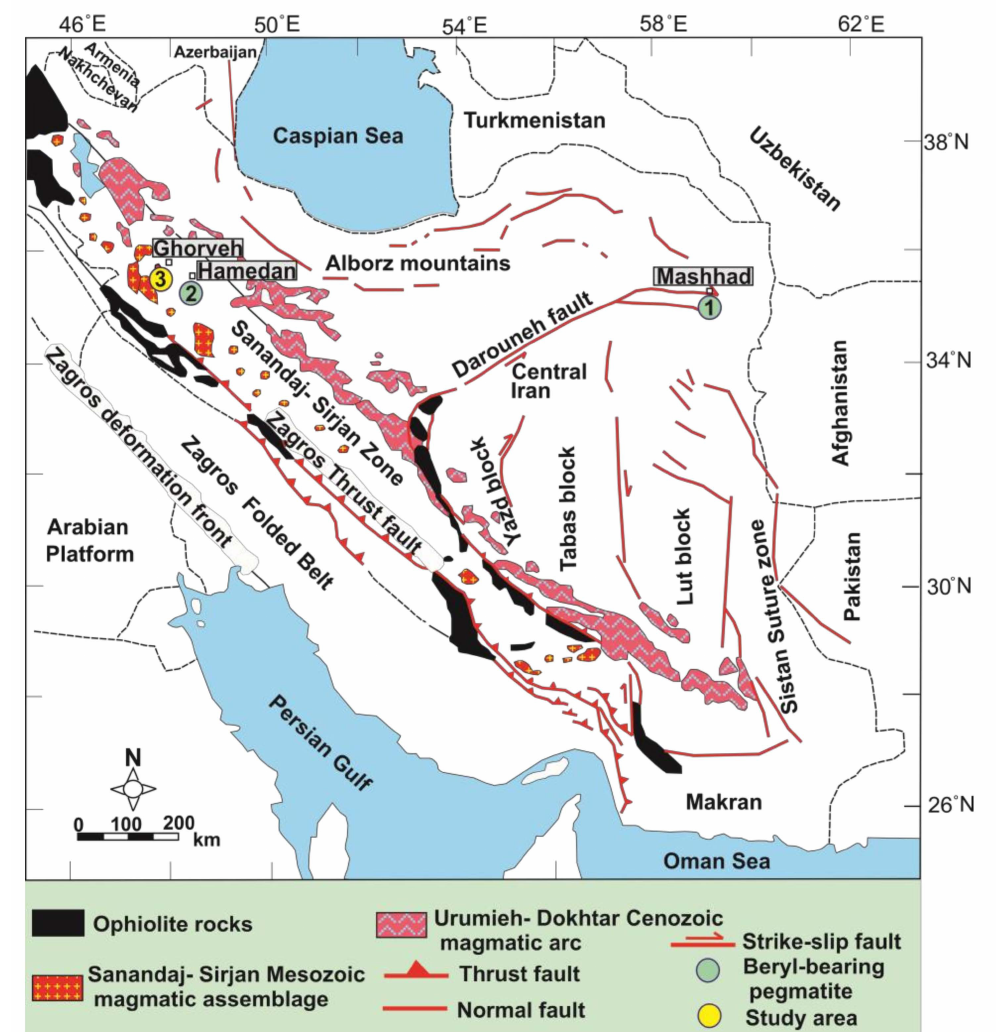
Figure 1. Structural map of Iran [33] with positions of beryl-bearing pegmatites including (1) Khajeh Morad [26,27], (2) Kamari and Zaman Abad [28,29], and (3) Ebrahim-Attar granitic pegmatite (this